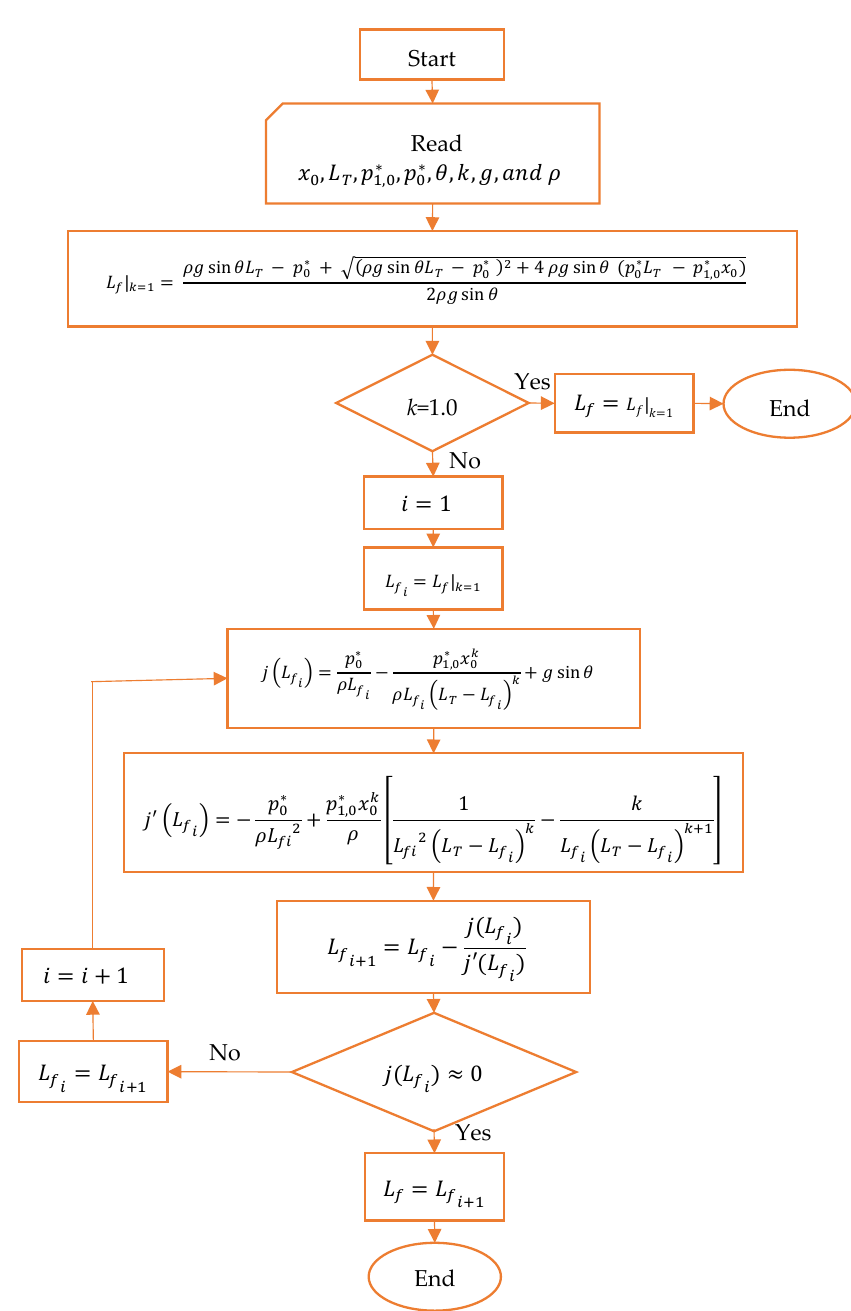
Figure 2 . Flowchart for computing the final position L f in a filling water process. Figure 2. Flowchart for computing the final position L f in a filling water